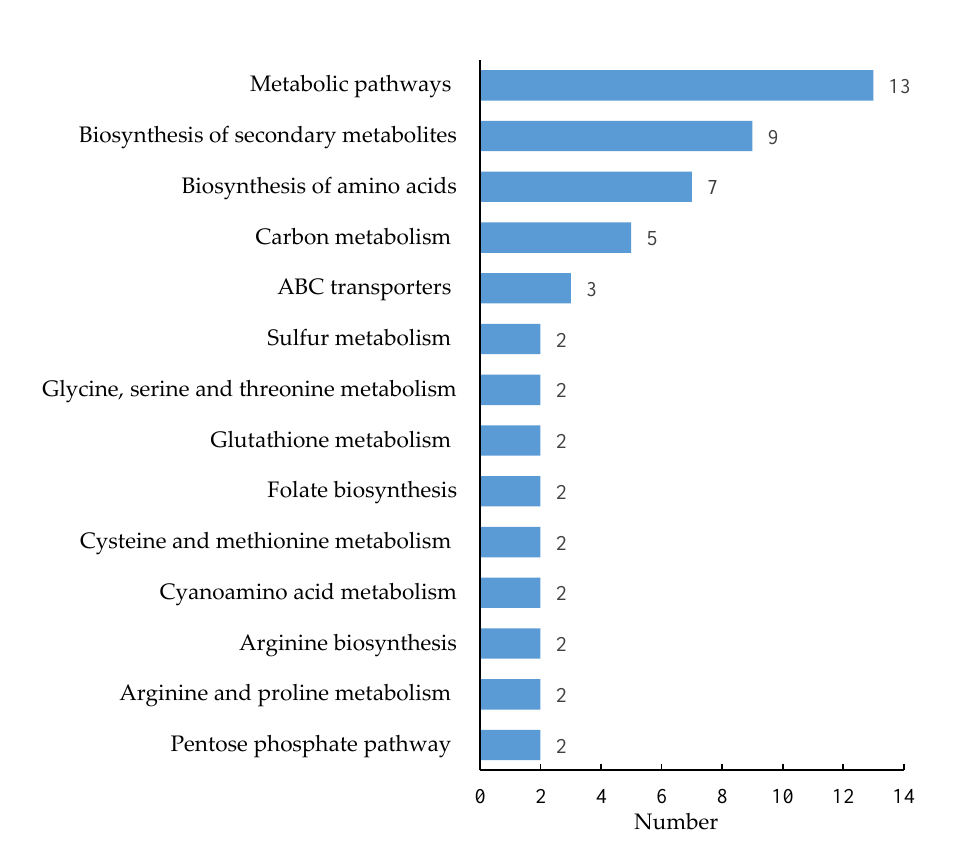
Figure 6. KEGG pathways enriched with DEMs after nitrogen supply.